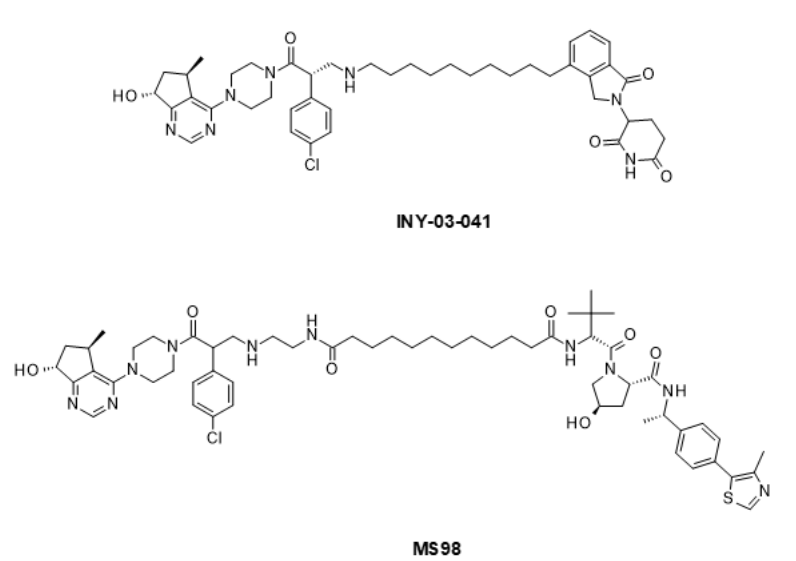
Figure 11. PROTAC degraders of